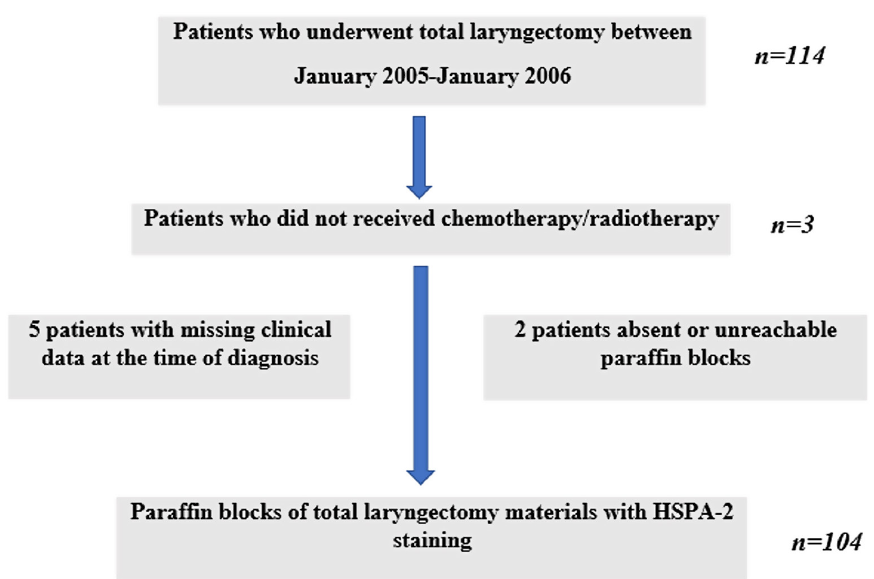
Figure 1. Study flowchart showing the included and excluded